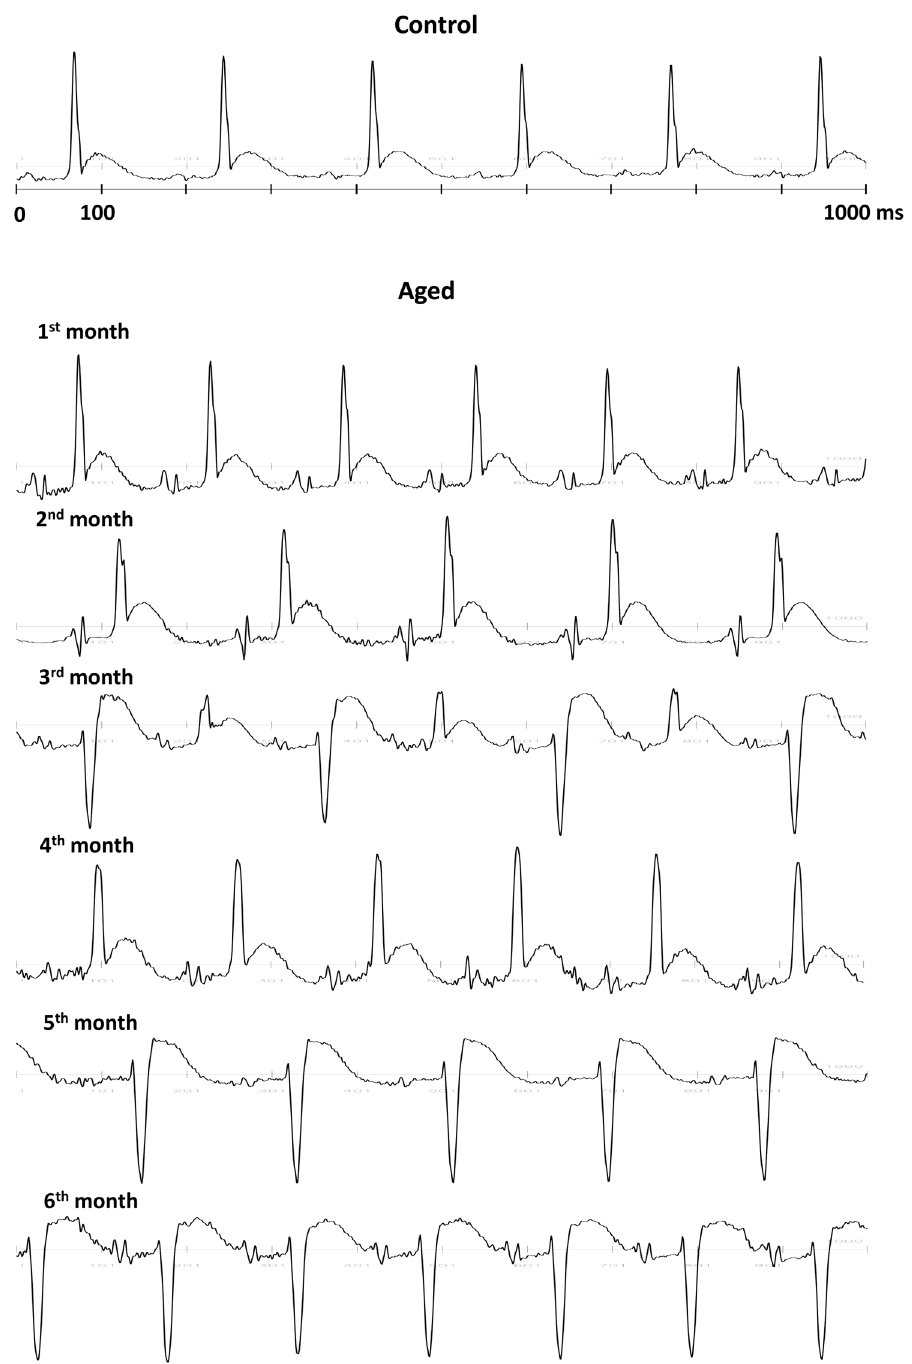
Figure 1. Telemetry ECG recordings. ECG traces (1 second) in a control animal (top) and in a representative aged animal displayed each month during the six-month